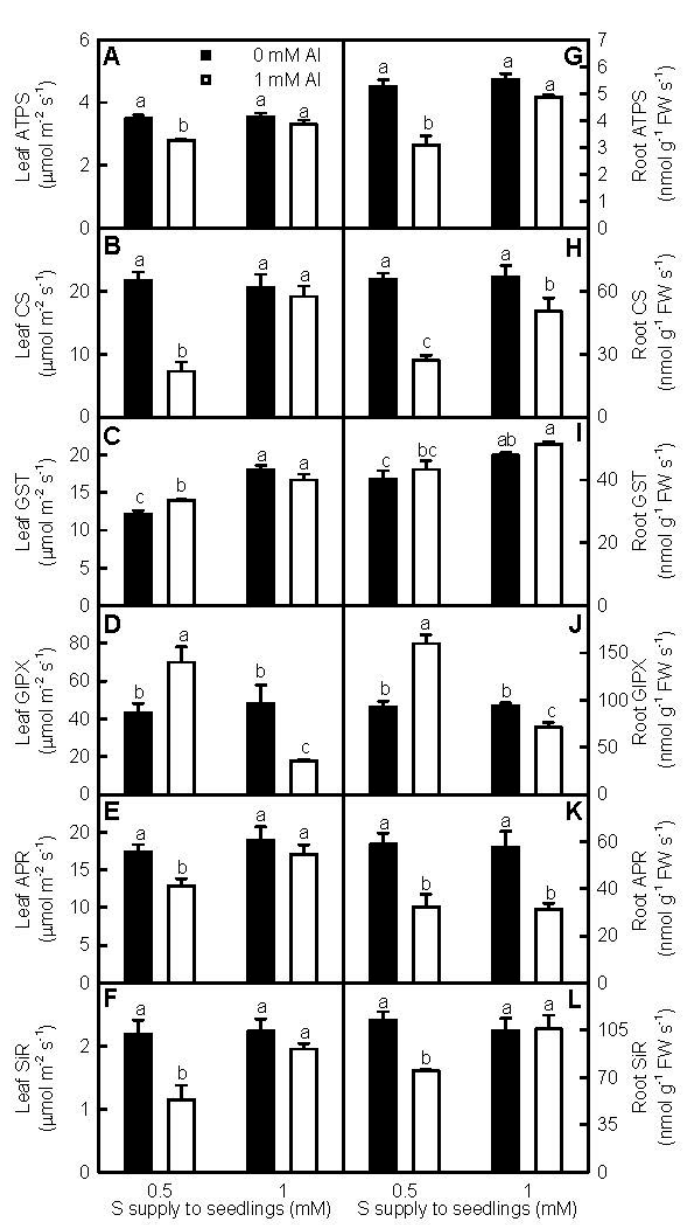
Figure 6. Effects of S and Al interactions on ATP sulfurylase(ATPS, A , G ), cysteine synthase (CS, B , H ), glutathione-S-transferase(GST, C , I ), glutathione peroxidase (GlPX, D , J ), adenosine 5 ′ -phosphosulphate reductase (APR, E , K ), andsulfite reductase (SiR, F , L ) activities in leaves ( A – F ) and roots ( G – L ). Bars represent means ± SE ( n = 4). Differences among the four treatments were analyzed by two (Al levels) × two (S levels) ANOVA. Different letters indicate a significant difference at p < 0.05.